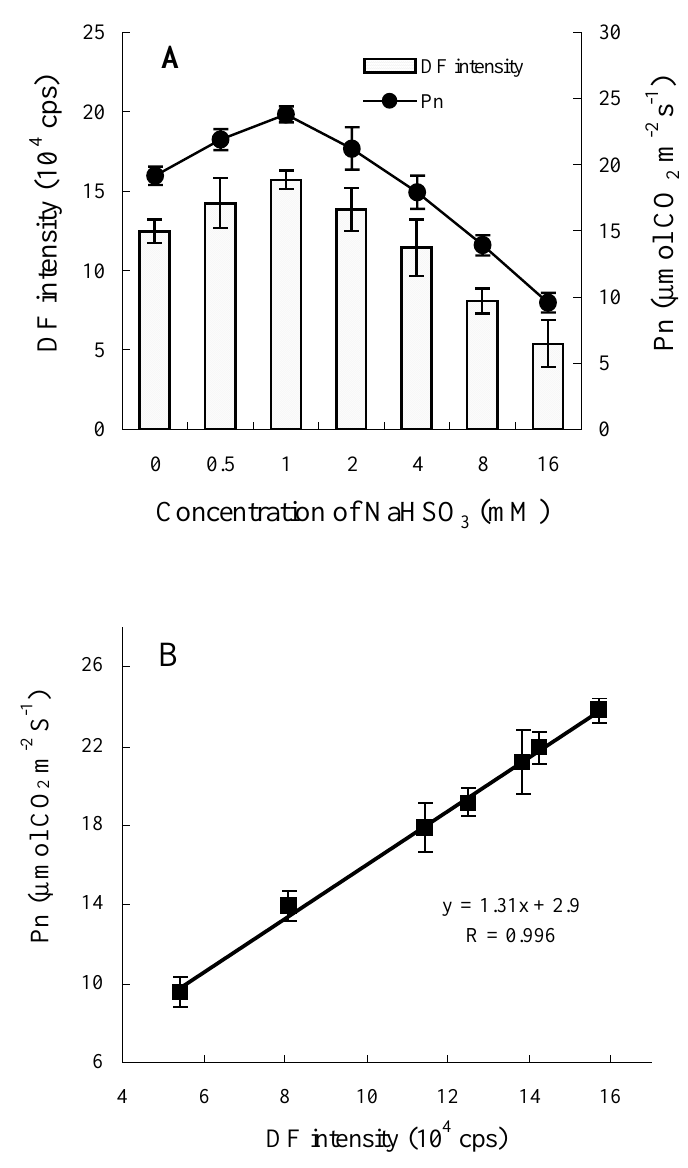
Figure 2. Effects of NaHSO on DF intensity and Pn of leaves of soybean ( Glycine max Zaoshu No. 3 18) seedlings. (A) Changes in DF intensity and Pn of leaves of soybean seedlings exposed to various NaHSO concentrations for 72 h. (B) The correlation between DF intensity and Pn (R = 0.996, P < 3 0.0001). In the figure each value is the mean ± S.E. of nine independent